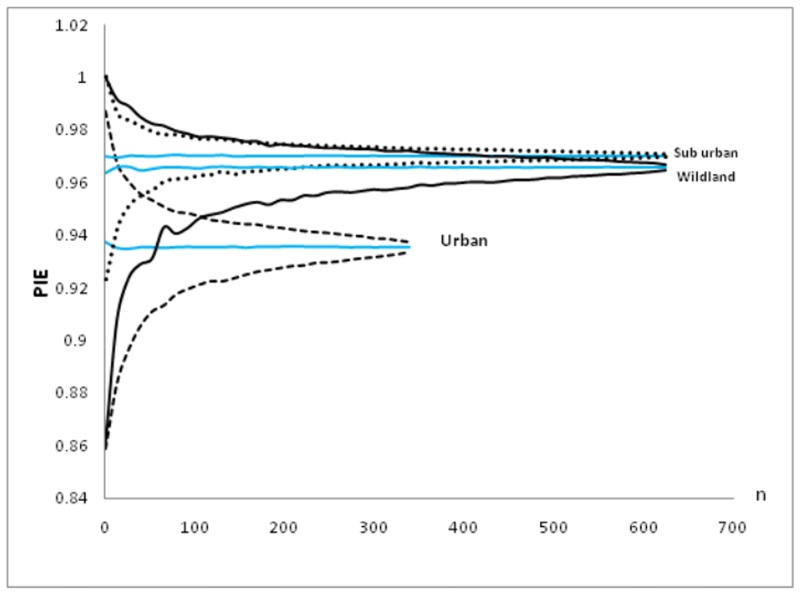
Species evenness shown by probability of interspecific encounter (PIE) for each habitat class (PIE is shown by thick lines whereas dotted lines show 95% confidence intervals).